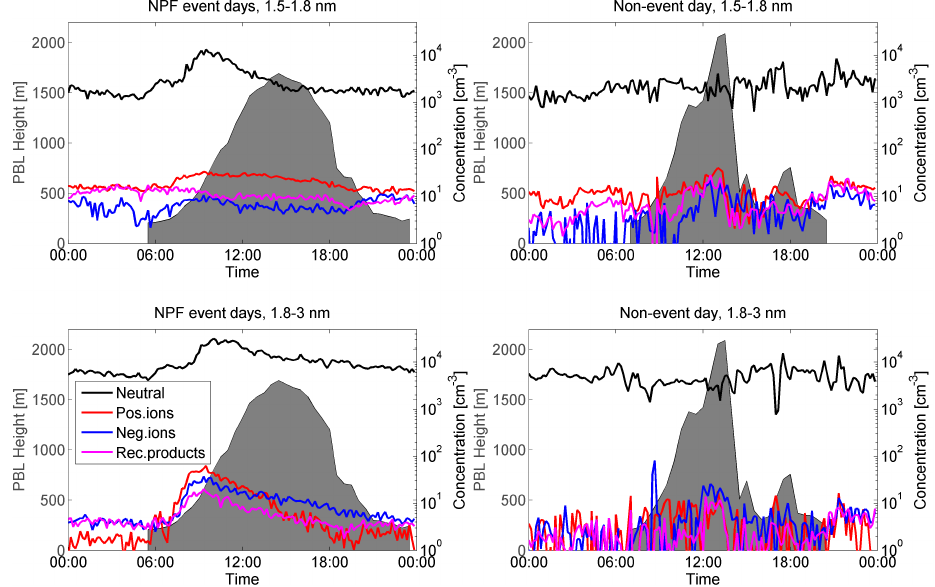
Figure 6. The median diurnal variation of the concentrations of neutral clusters (black line), positive ions (red line), negative ions (blue line) and recombination products (magenta line) on NPF event days and on the only non-event day (6 July 2012). In addition, the PBL height is shown in grey. Time is UTC + 1h.